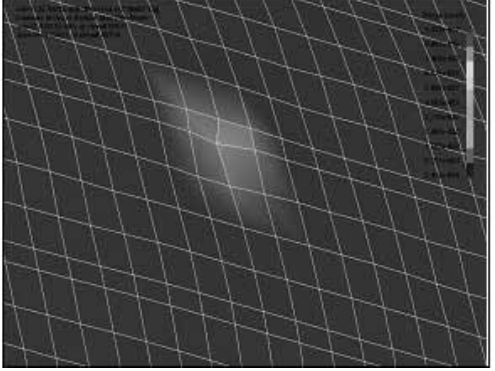
Fig. 35. Plastic strain in fuselage outer skin simulated by the revised